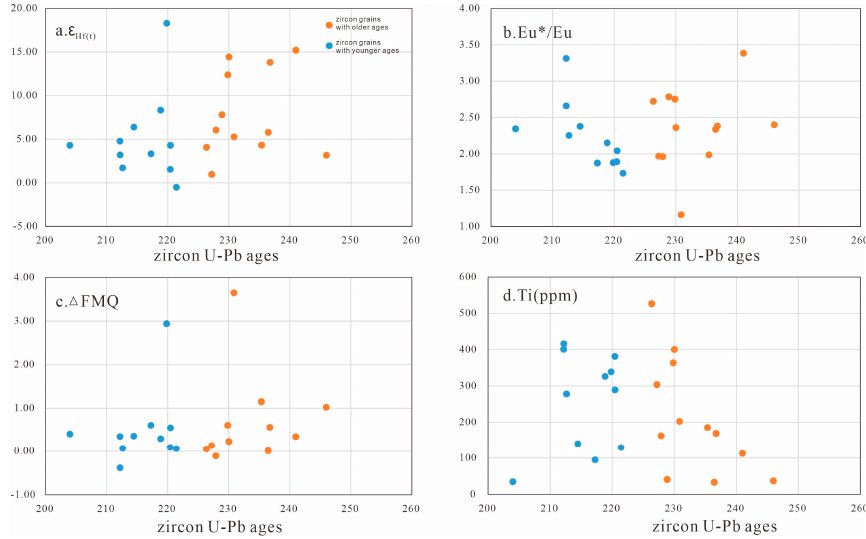
Figure 5. Zircon geochemical differences for the Laocheng appinite. Zircon U-Pb ages vs. ε Hf ( t ) ( a ), Eu*/Eu anomalies ( b ), △ FMQ ( c ) and Ti contents ( d ) diagrams. Eu*/Eu anomalies ( b ), (cid:52) FMQ ( c ) and Ti contents ( d ) diagrams.